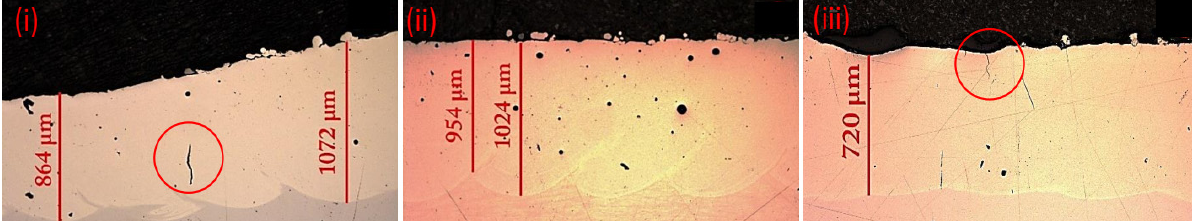
Figure 3. ( i ) Mo-HEA-S235JR with manufacturing crack in the coating, ( ii ) Mo-HEA-316L with no crack in the coating, and ( iii ) Al-HEA-304L samples with crack after the exposure.